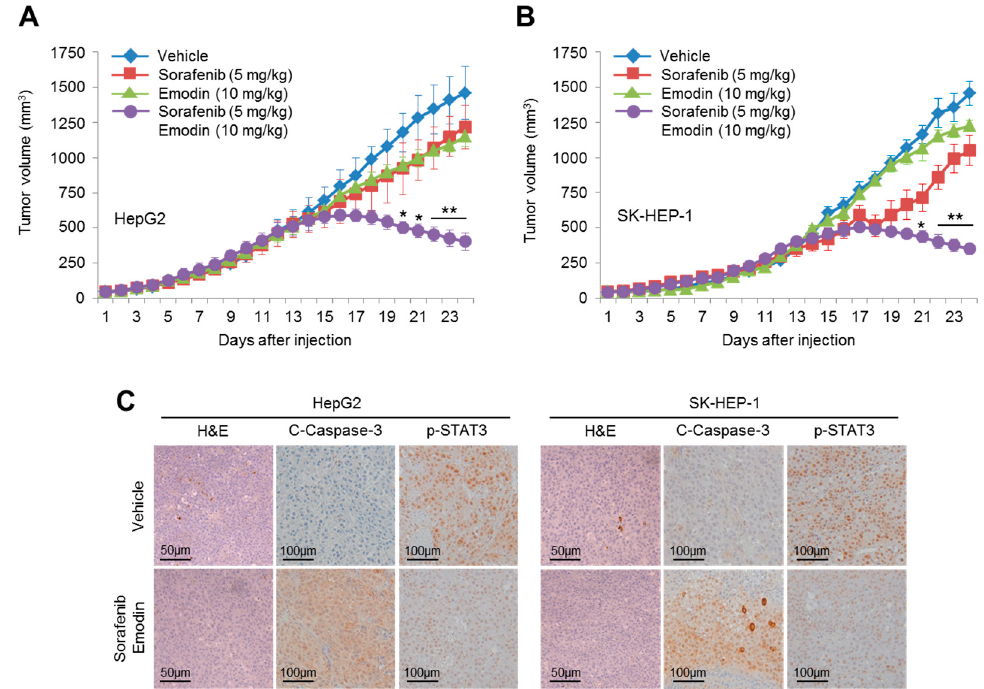
Figure 8. Emodin synergistically increased the anti-cancer efficacy of sorafenib in vivo. ( A ) HepG2 and ( B ) SK-HEP-1 cells were injected into the flanks of nude mice, and the mice were then divided into four groups. When the tumor volumes reached 250 mm 3 , the mice were treated with DMSO, emodin (10 mg/kg/day), sorafenib (5 mg/kg/day), or the combination (10 mg/kg/day emodin and 5 mg/kg/day sorafenib) for three weeks; with the tumor volumes measured daily. Tumor growth curves are plotted as the mean ± SEM ( n = 7); * p < 0.05 and ** p < 0.01. ( C ) The combination of emodin and sorafenib decreased the phosphorylation of STAT3 and increased cleaved-caspase-3. The protein expression in xenografted tumor tissues was measured by immunohistochemistry using the indicated antibodies.